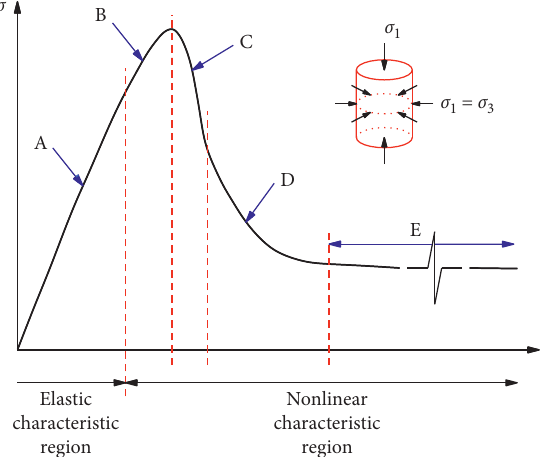
Figure 8: Typical compressive stress-strain curve of rock under certain confining pressure condition. A, linear elastic case; B, prepeak nonlinear phase; C, brittle properties; D, softening properties; E, residual strength. Figure 9: Stress-strain curves of numerical simulation and ex-